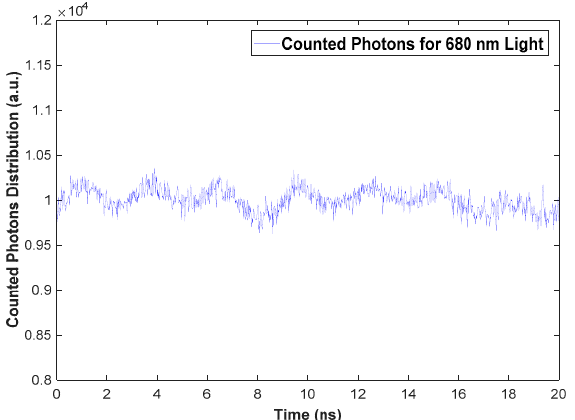
Figure 7. Histogram of PTA distributions for 10 7 counted photons in all time bins (1000 bins for 20 ns range).